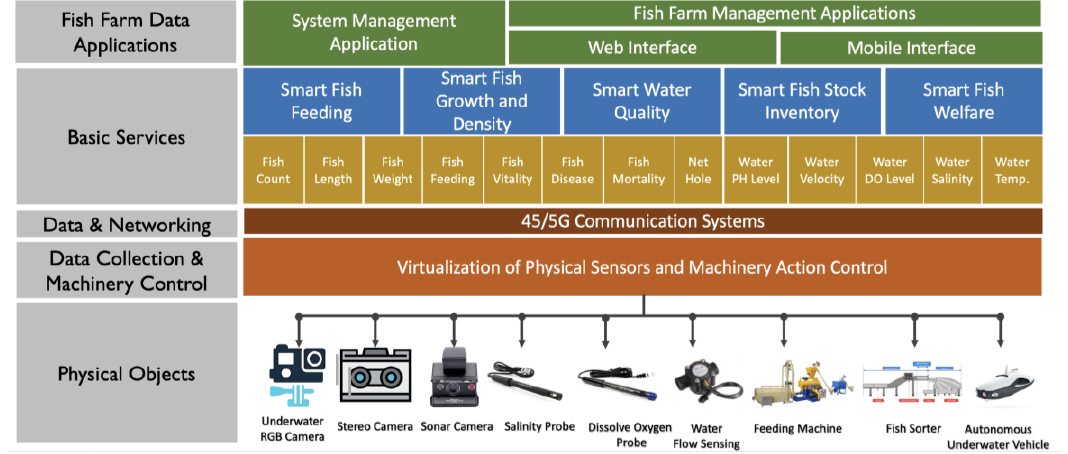
Figure 2. Digital aquaculture architecture based on Digital Twins [8].